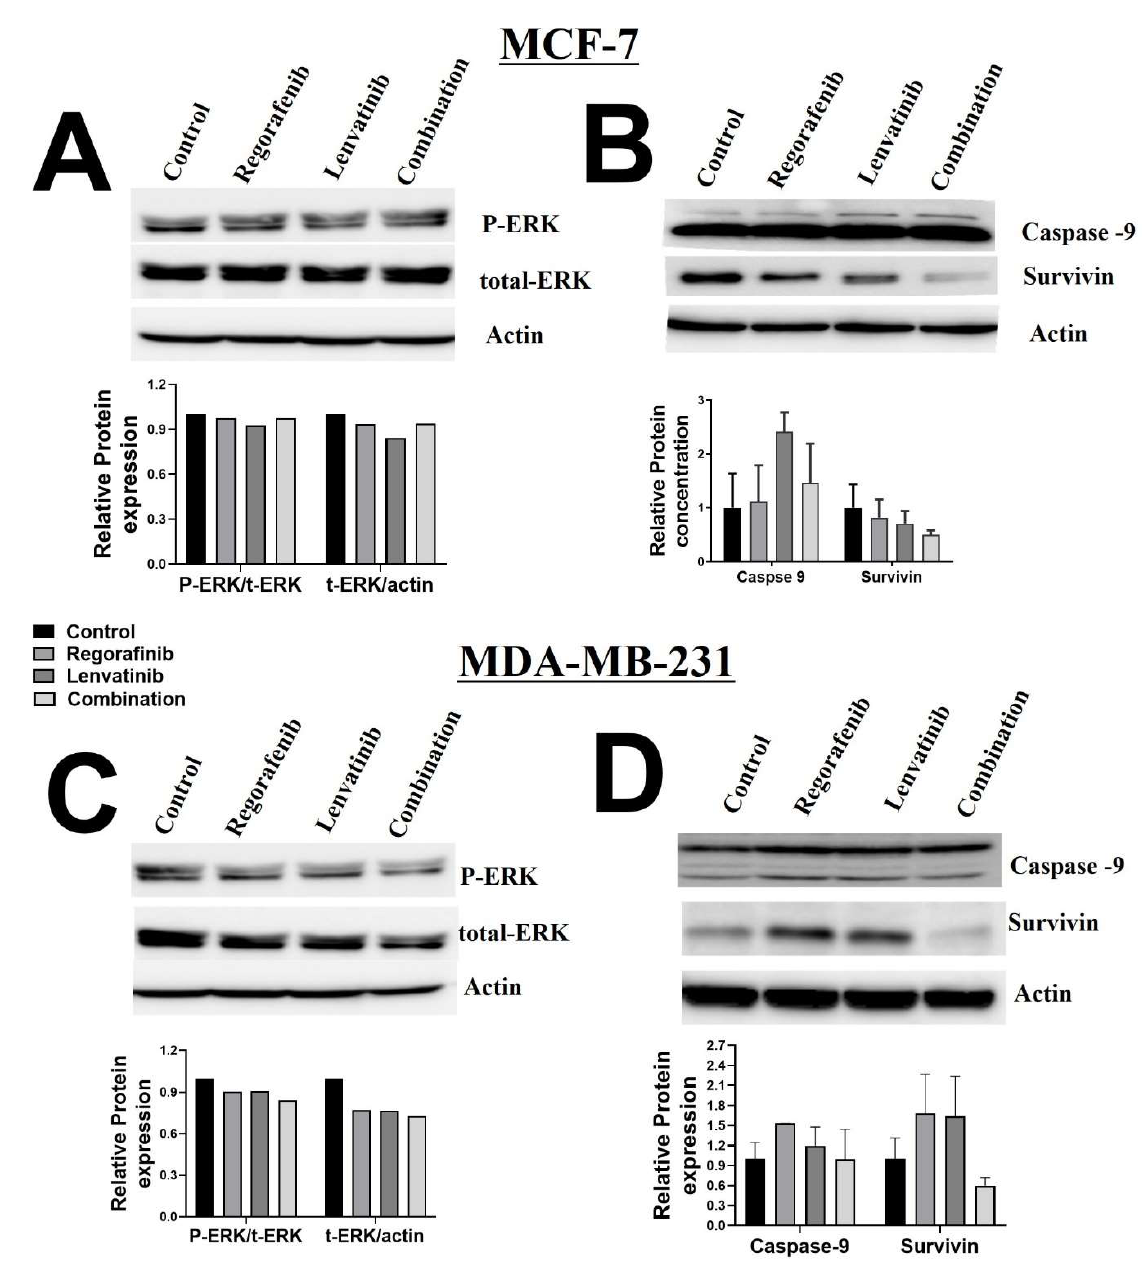
Figure 4. Effect of Regorafenib, Lenvatinib, and combination treatment on protein levels of p-ERK, t-ERK, Capase9, Survivin, and Actin in ( A ) MCF-7 and ( B ) MDA-MB-231 ( n = 1–2/group) cells. Cells were treated with 1 µM Regorafenib for 48 h, 10 µM Lenvatinib for 48 h, and 1 + 10 µM combination for 48 h. Change in protein levels was evaluated using Western blotting.